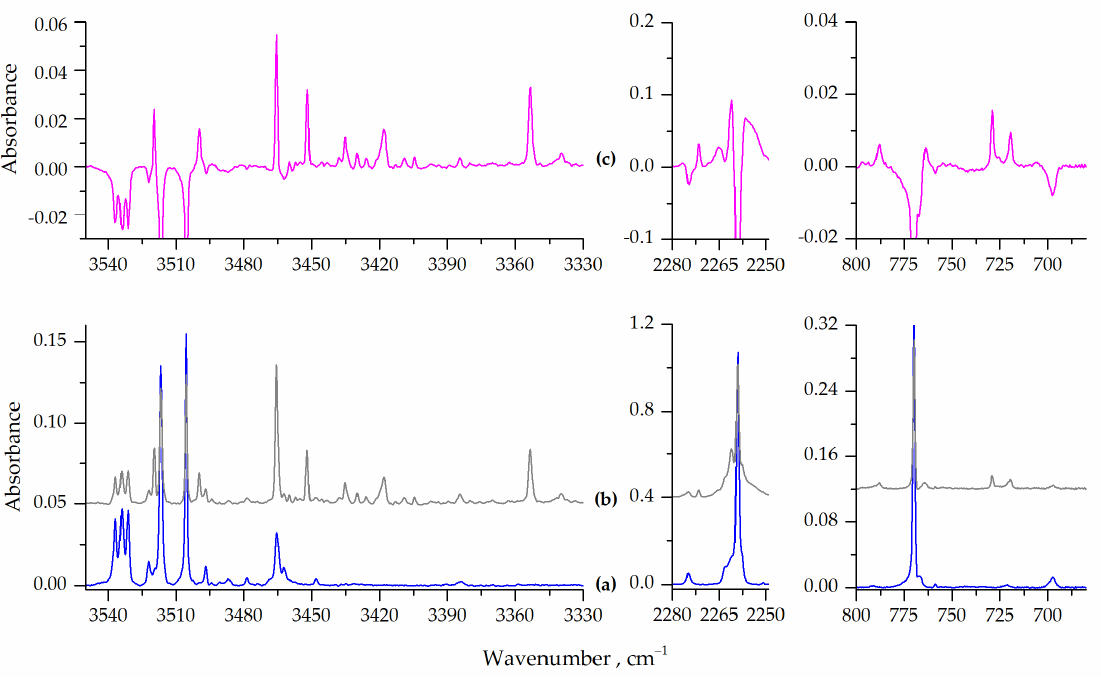
Figure 4. Bottom panels: the ν NH, ν as NCO and δ NCO vibrational spectral regions for HNCO/Ar = 1/6000 after deposition ( a , blue line) and after subsequent 10 min annealing at 33 K ( b , grey line). Top panels: the difference spectrum ( c , pink line) obtained by subtracting the spectrum ( a ) from the spectrum ( b ).